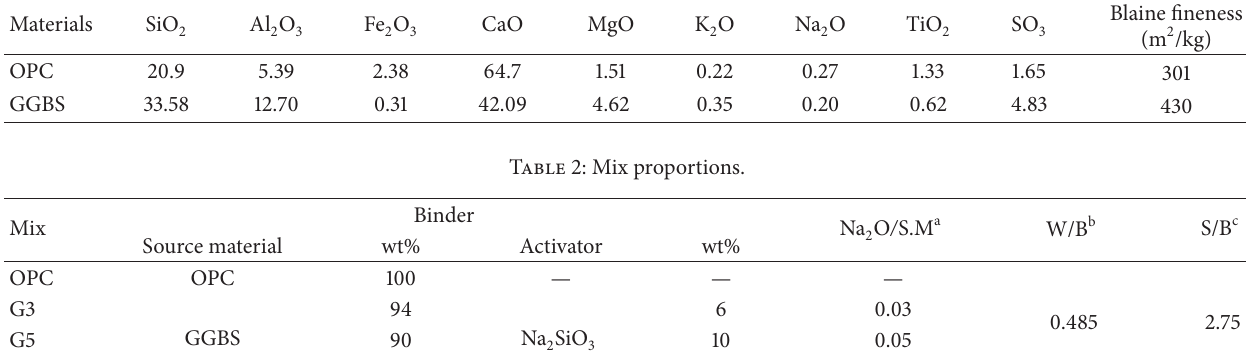
Table 1: Chemical compositions of the source materials and alkali activators used (% by mass). Materials